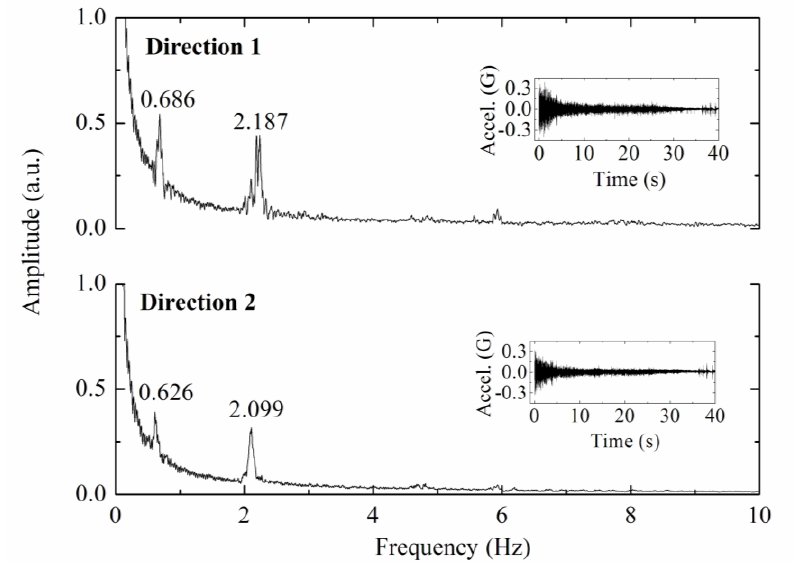
Figure 9. Frequency spectra obtained from the acceleration data recorded in the tower, upon a train transit. The origin corresponds to the instant when the train last wagon passed in the position perpendicular to the tower. Time-acceleration data are shown in the